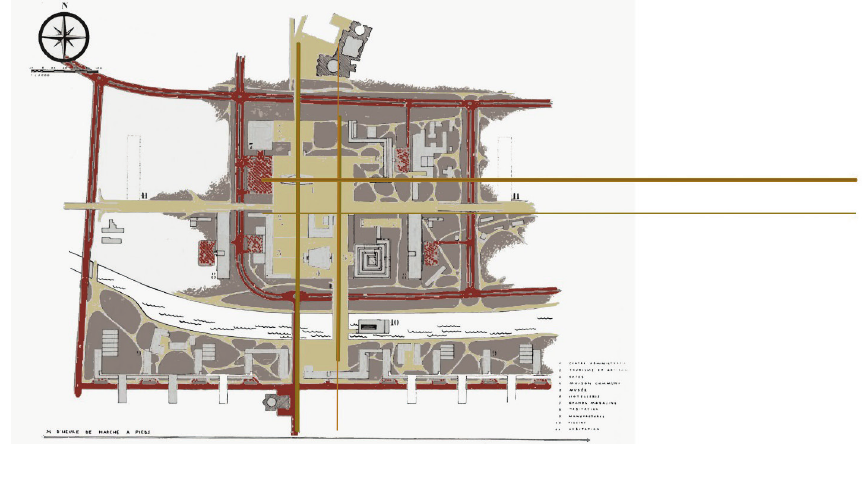
fig. 6. The civic centre of